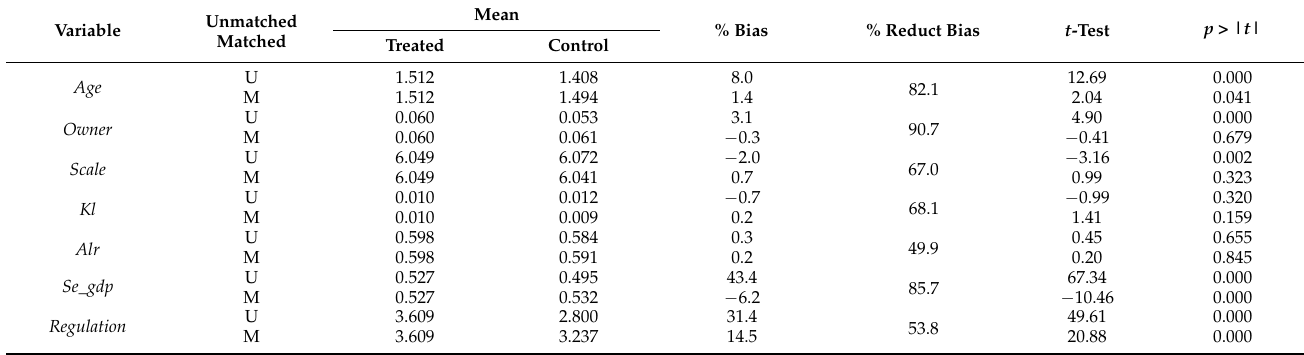
Table A3. Results of radius matching balance test for propensity